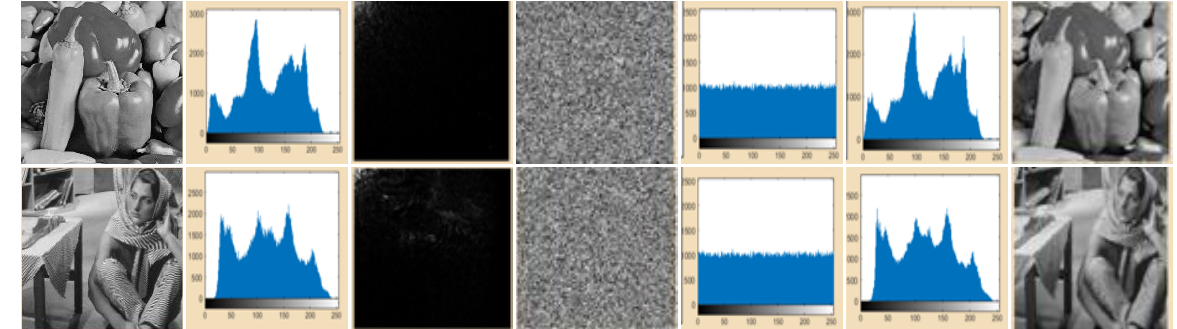
Figure 7 . columns 1-3 are original Images (Courtesy of SIPI image data base), original image histogram, DCT based compressed image respectively, column 4 is DES encrypted image, column 5 is compressed-encrypted image histogram, column 6 is decompressed-decrypted image histogram, and column 7 is decompressed- decrypted image.